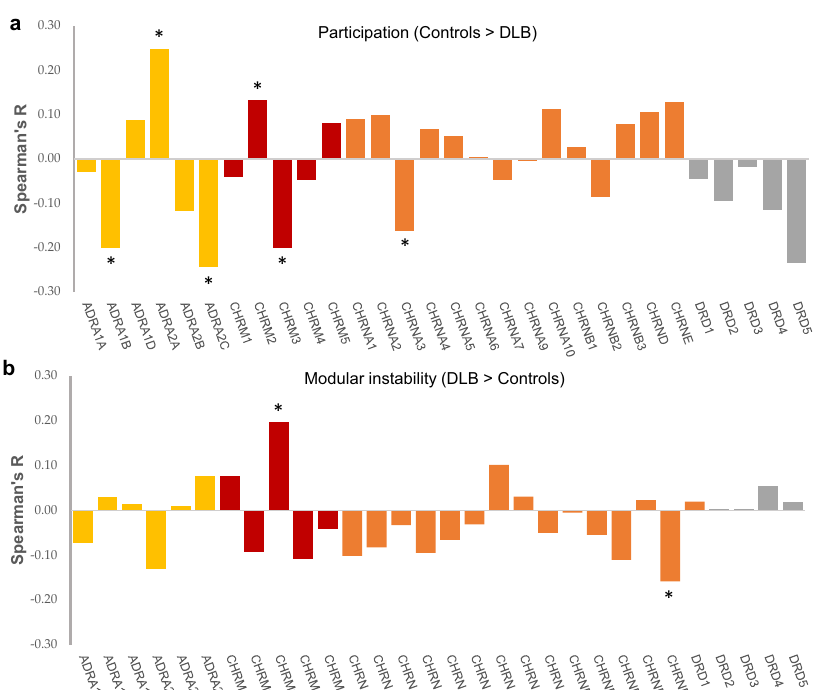
Fig. 5 Spearman correlations between regional cortical expression of adrenergic, cholinergic (muscarinic and nicotinic), and dopaminergic receptors and difference in topological parameters seen between controls and DLB. a Correlation between gene expression and difference in participation (integration) between controls and DLB showed a signi fi cant relationship between differential expression of adrenergic and cholinergic receptors with later con fi rmation with statistical testing showing signi fi cant differences for ADRA2A and CHRM2 . b Correlation between gene expression and difference in modular instability ( fl exibility) (DLB > Controls) highlighting signi fi cant relationships with cholinergic receptor expression, later con fi rmed for CHRM3 . See Supplementary Table 2 for gene names. *FDR <